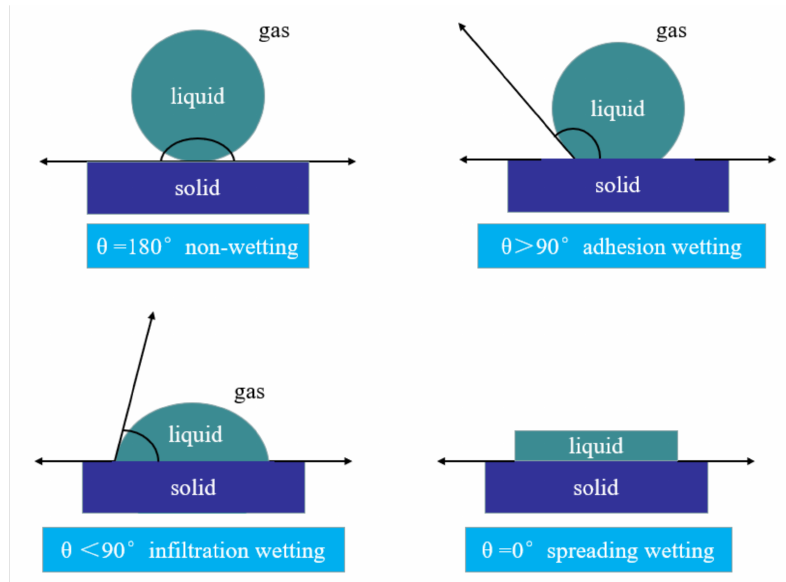
Figure 25. Droplet wetting